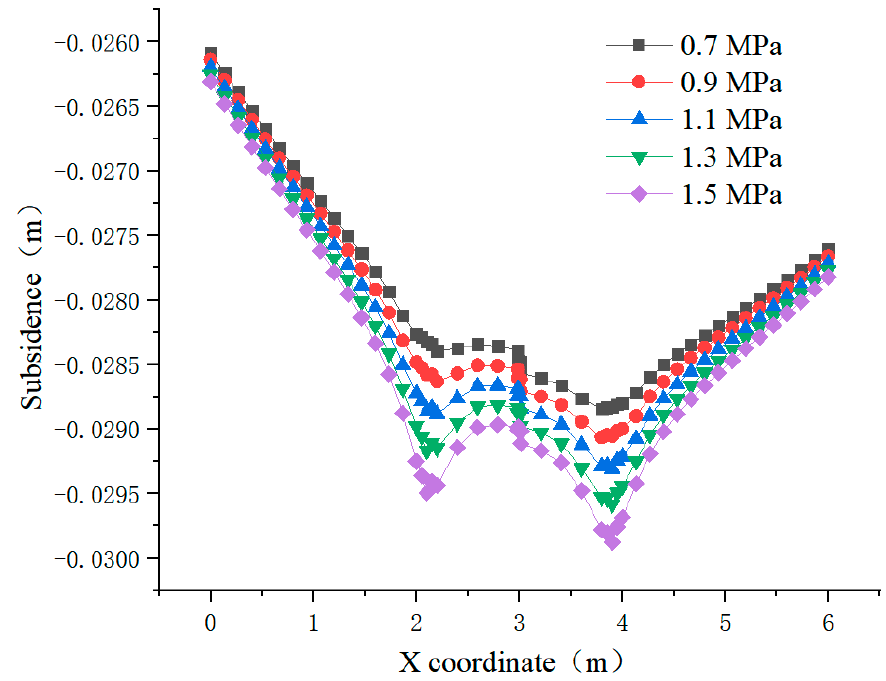
Figure 11. Distribution of dam subsidence at 14.625 m under different load amplitudes.